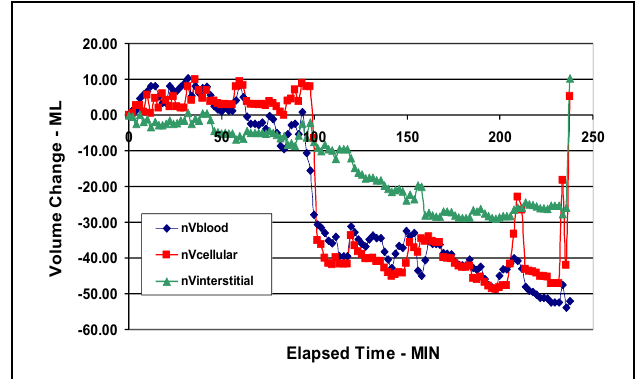
Fig. 6: Compartment volumes.